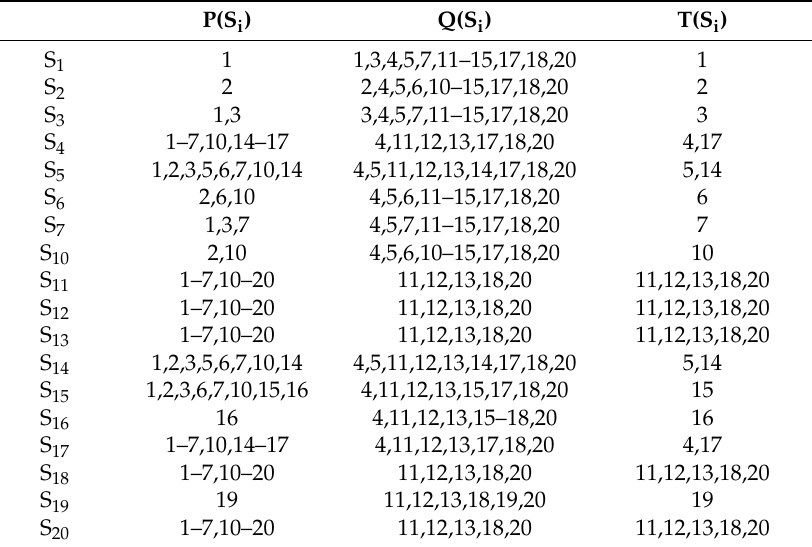
Table 7. Second level of reachability set, leading set, and their